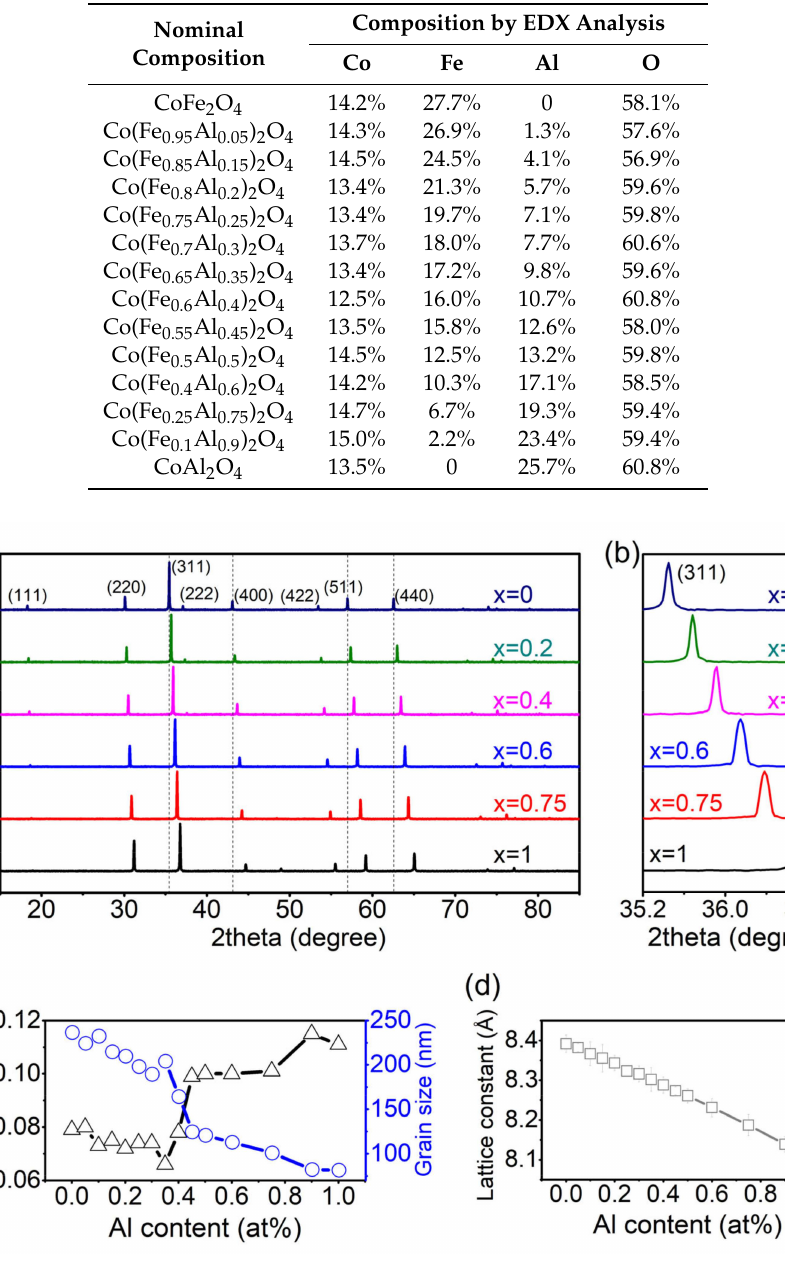
Figure 1. (Color online) ( a ) XRD patterns for some selected compositions Co(Fe 1 − x Al x ) 2 O 4 ( x = 0, 0.2, 0.4, 0.6, 0.75, 1); the dashed lines are guidance for the shift of reflections; ( b ) the (311) reflections of the XRD profiles in ( a ); ( c ) the composition dependence of full width at half maximum (FWHM) and the calculated grain size; ( d ) the composition dependence of lattice